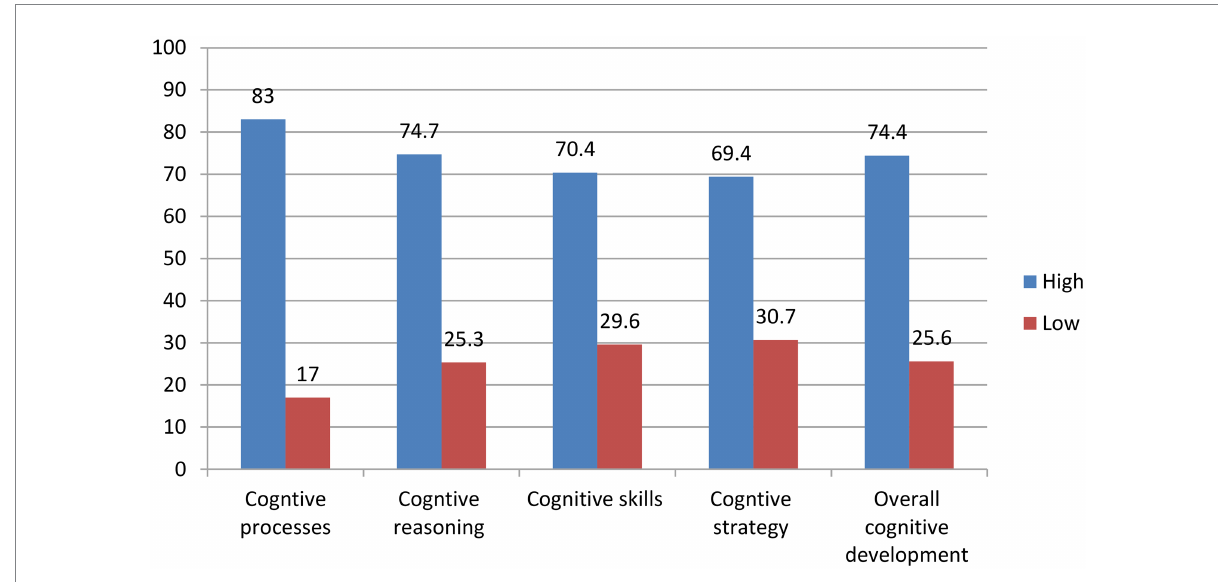
FIGURE 4 Respondents’ appraisal of cognitive development.